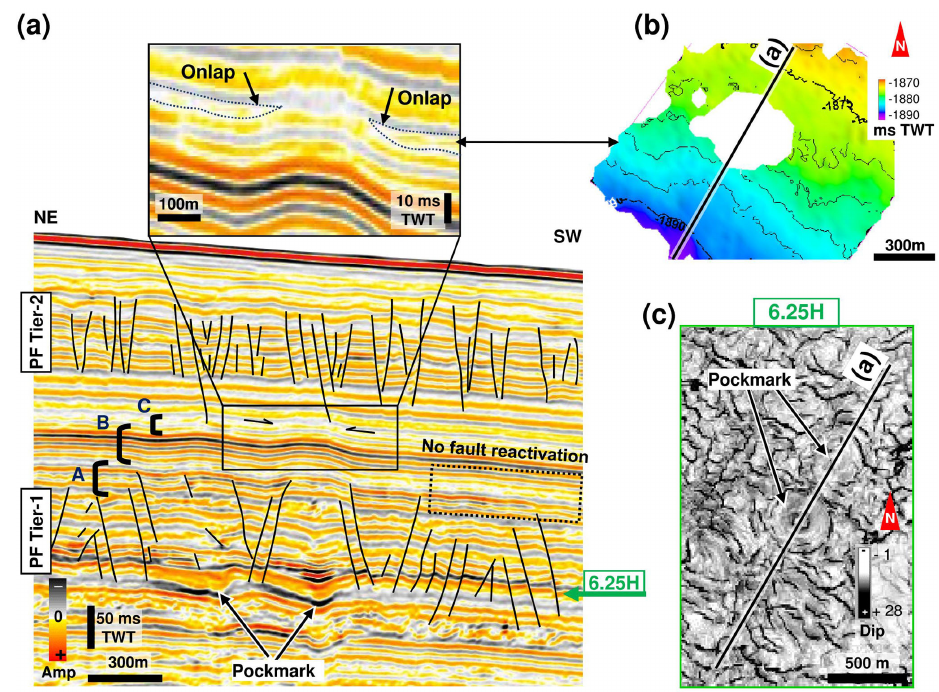
Figure 4. Direct evidence for the time when PF activity ceased. (a) Profile transecting outward-facing concentric faults (defining a horst block) above a buried pockmark (annotated) in PF Tier-1. A minority of fault upper tips exist in interval A above Tier-1 (interval A); the first non-faulted stratum (interval B) is folded above the horst with an isopachous thickness; the topmost reflection (in interval C) pinches out on the positive relief above the horst as indicated by black arrows. (b) Two-way time map of the onlap termination of the horizon (in interval C) against the horst. (c) A dip map at the base of Tier-1 showing concentric PF around the circular pockmark shown in (a) .